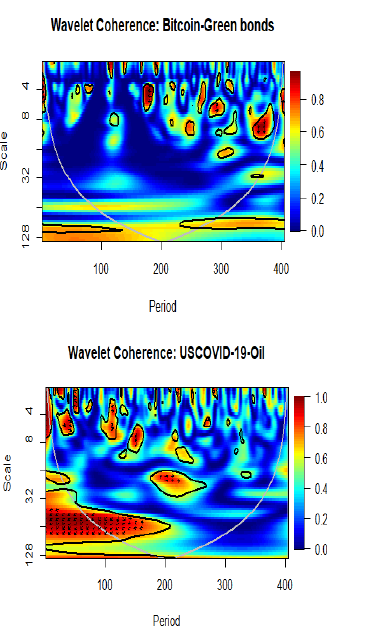
Figure 3. Wavelet coherence of all variables.